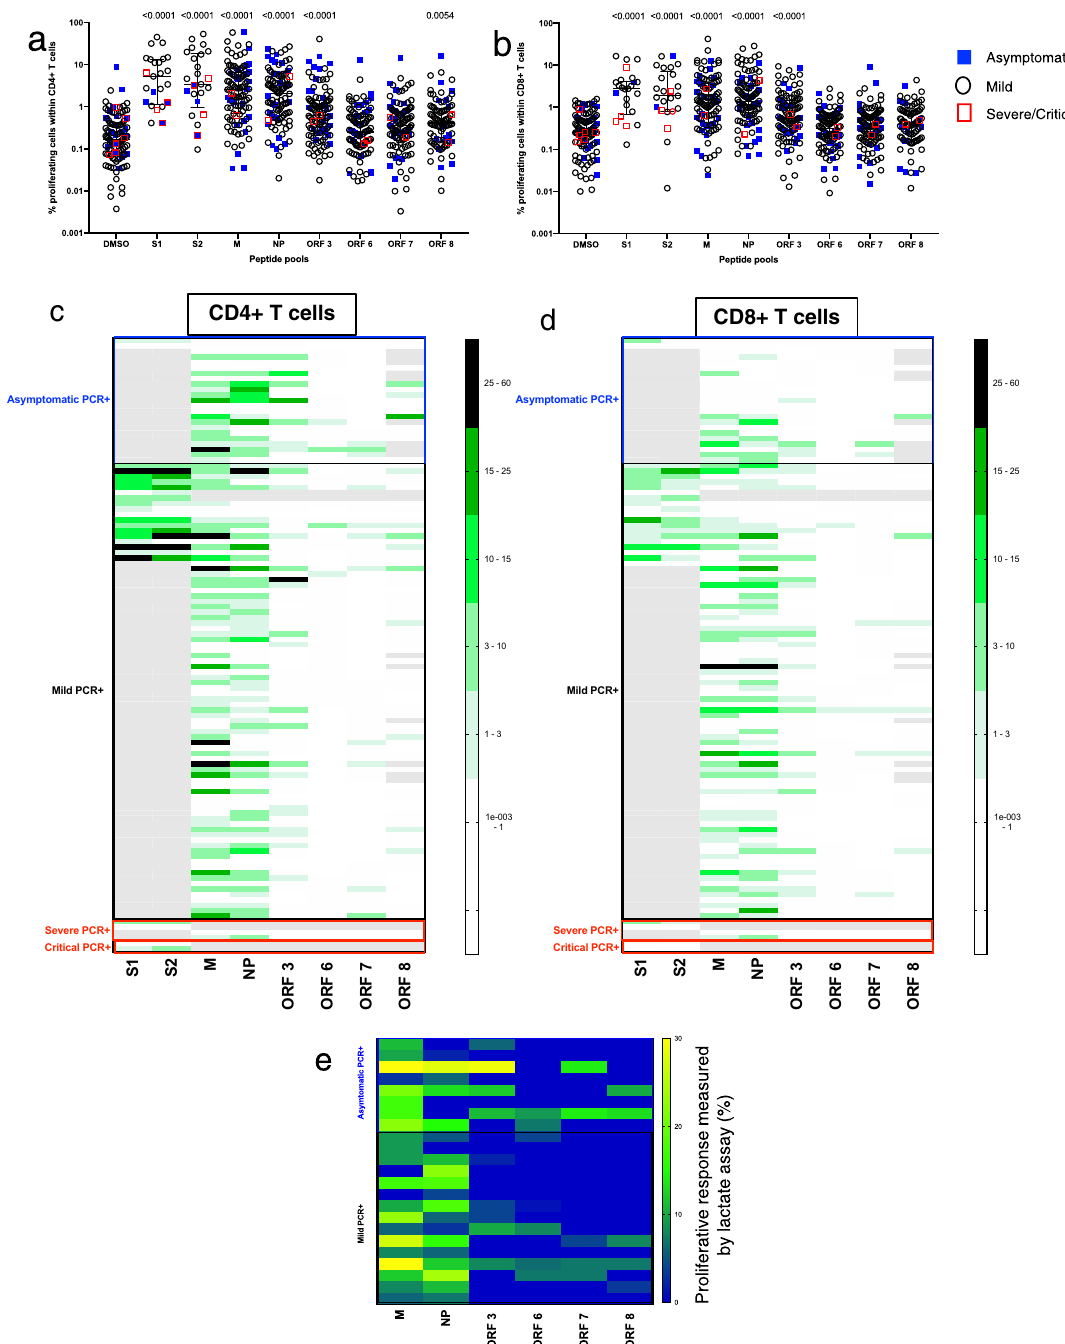
Fig. 3 Proliferative responses in CD4 + and CD8 + T cells to key SARS-CoV-2 proteins. Plot showing raw frequency (without background subtraction) of proliferating cells in response to peptide pool stimulation in 113 volunteers in a CD4 + and b CD8 + T cells to DMSO (media), and overlapping peptide pools spanning S1, S2, M, NP, ORF 3, ORF6, ORF7 and ORF8. c Heatmap showing the magnitude of proliferative responses to overlapping peptide pools spanning SARS-CoV-2 proteome in CD4 + T cells and d CD8 + T cells following background subtraction. Scales on the heatmap represent the magnitude of proliferating cells. Only data points >1% corresponding to mean + 2× SD in DMSO only well for both CD4 + and CD8 + T cells are shown. The grey box indicates absent data where tests were not run due to sample or peptide availability. e Cellular lactate proliferative response in convalescent mild and asymptomatic HCWs ( n = 23 asymptomatic and mild symptoms) at day 4 revealed a variable response to M, NP, ORF 3, 6, 7 and 8. Heatmaps show background-subtracted responses. Each data point represents a single volunteer and plots show median with error bars indicating ± IQR. Where indicated, ns not signi fi cant, * = <0.05, ** = <0.01, *** = <0.001 and **** = <0.0001 by Kruskal – Wallis one-way ANOVA, with Dunn ’ s multiple comparisons test for shown in Supplementary Tables 4 and 5. Number of volunteers for a – d : asymptomatic = 23, mild = 84, severe = 4, critical =